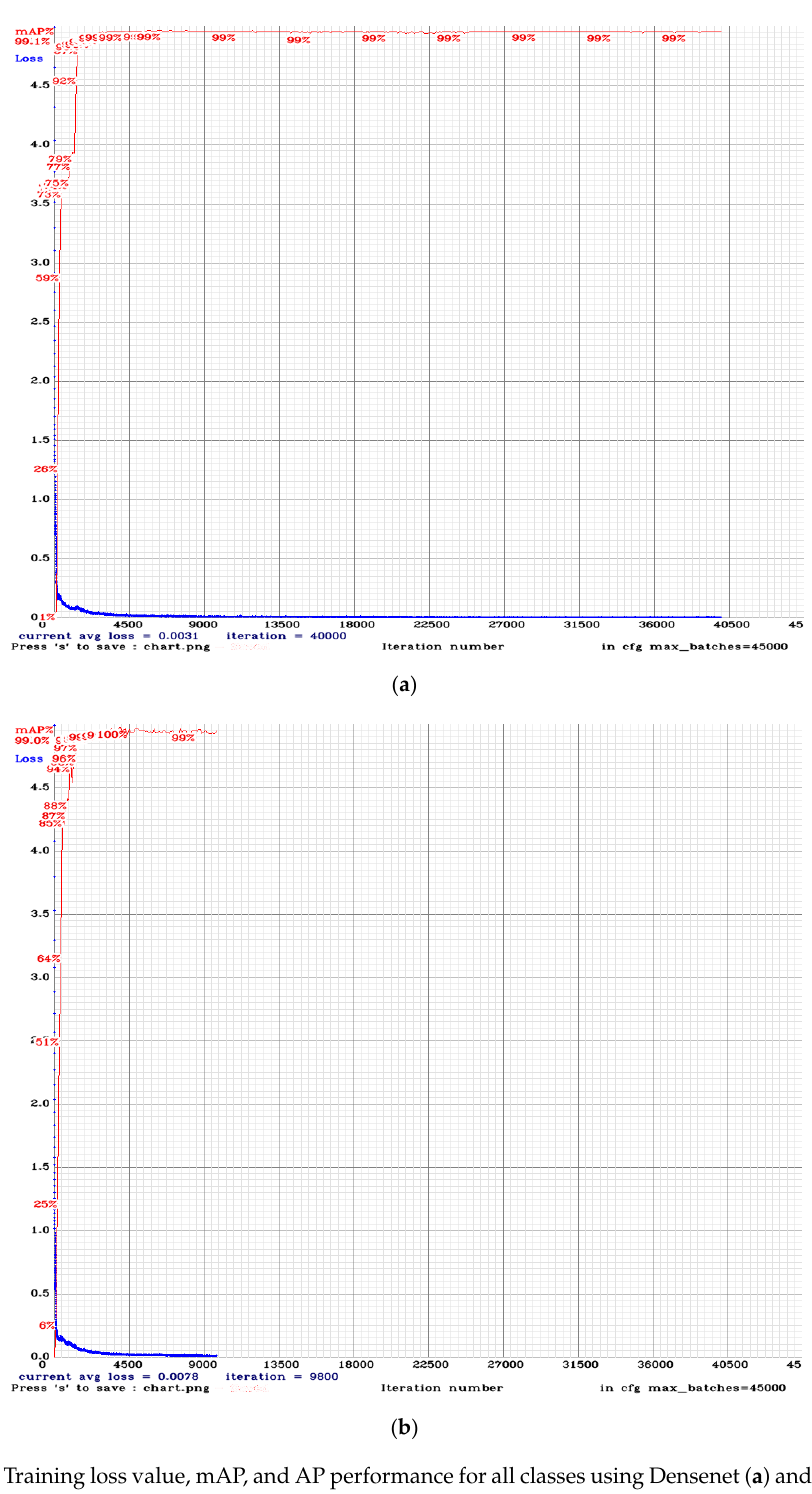
Figure 6. Training loss value, mAP, and AP performance for all classes using Densenet ( a ) and Densenet SPP ( b ).